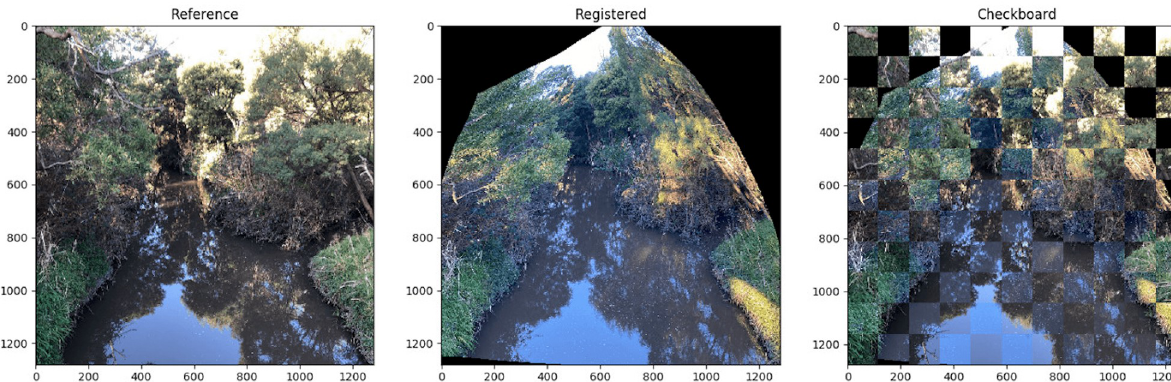
Fig 6. An example of image registration is applied to an input and sensed image.